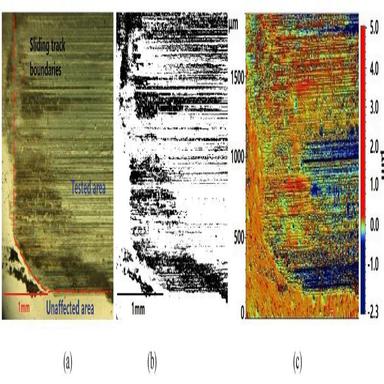
Observation of the sooth (non-textured) steel counter-surface using (a) optical microscopic image, (b) binary image converted from microscopic image, and (c) surface topographic image.